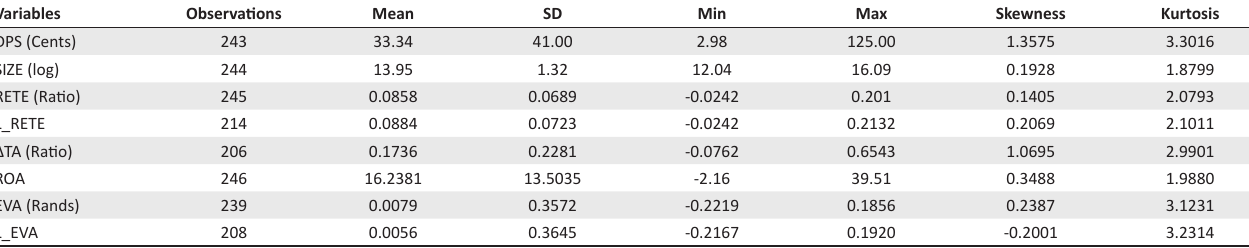
TABLE 6: Descriptive statistics for all variables of Panel 3: Growth companies.